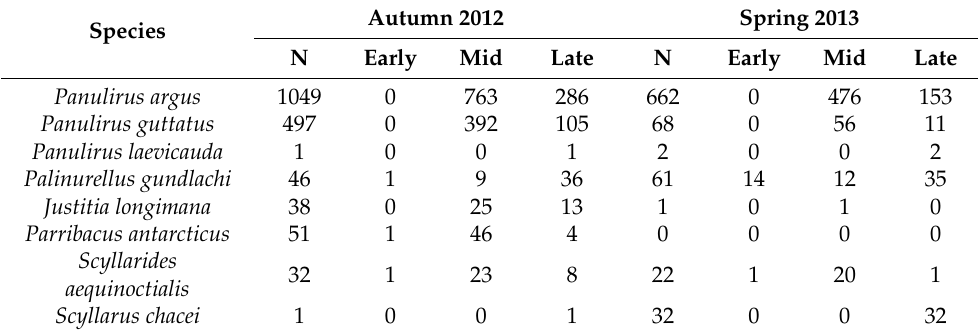
Table 2. Number of phyllosomata of each species categorized into early-stage, mid-stage, and late-stage larvae by cruise (N = total number of larvae).